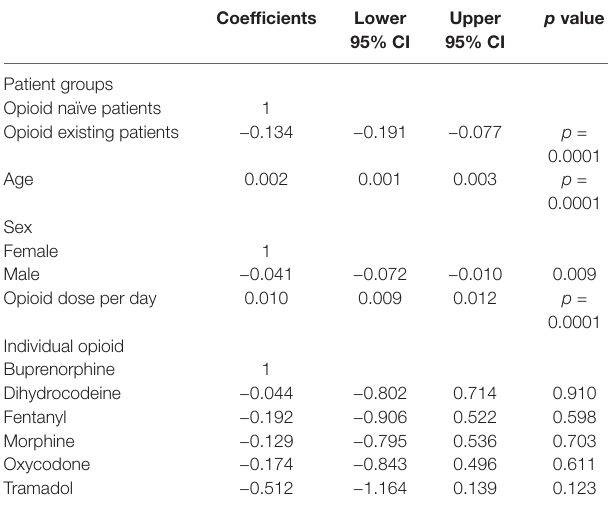
TABlE 2 | Results from the generalized linear model regression of the factors influenced